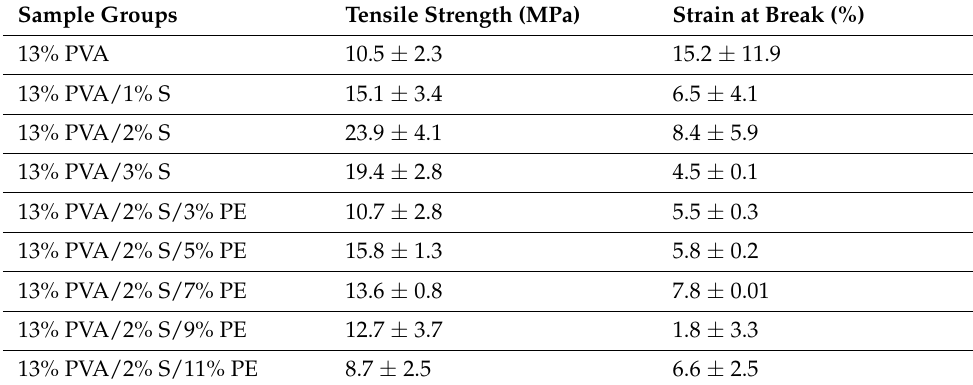
Table 3. The tensile strength and strain values of the 3D-printed